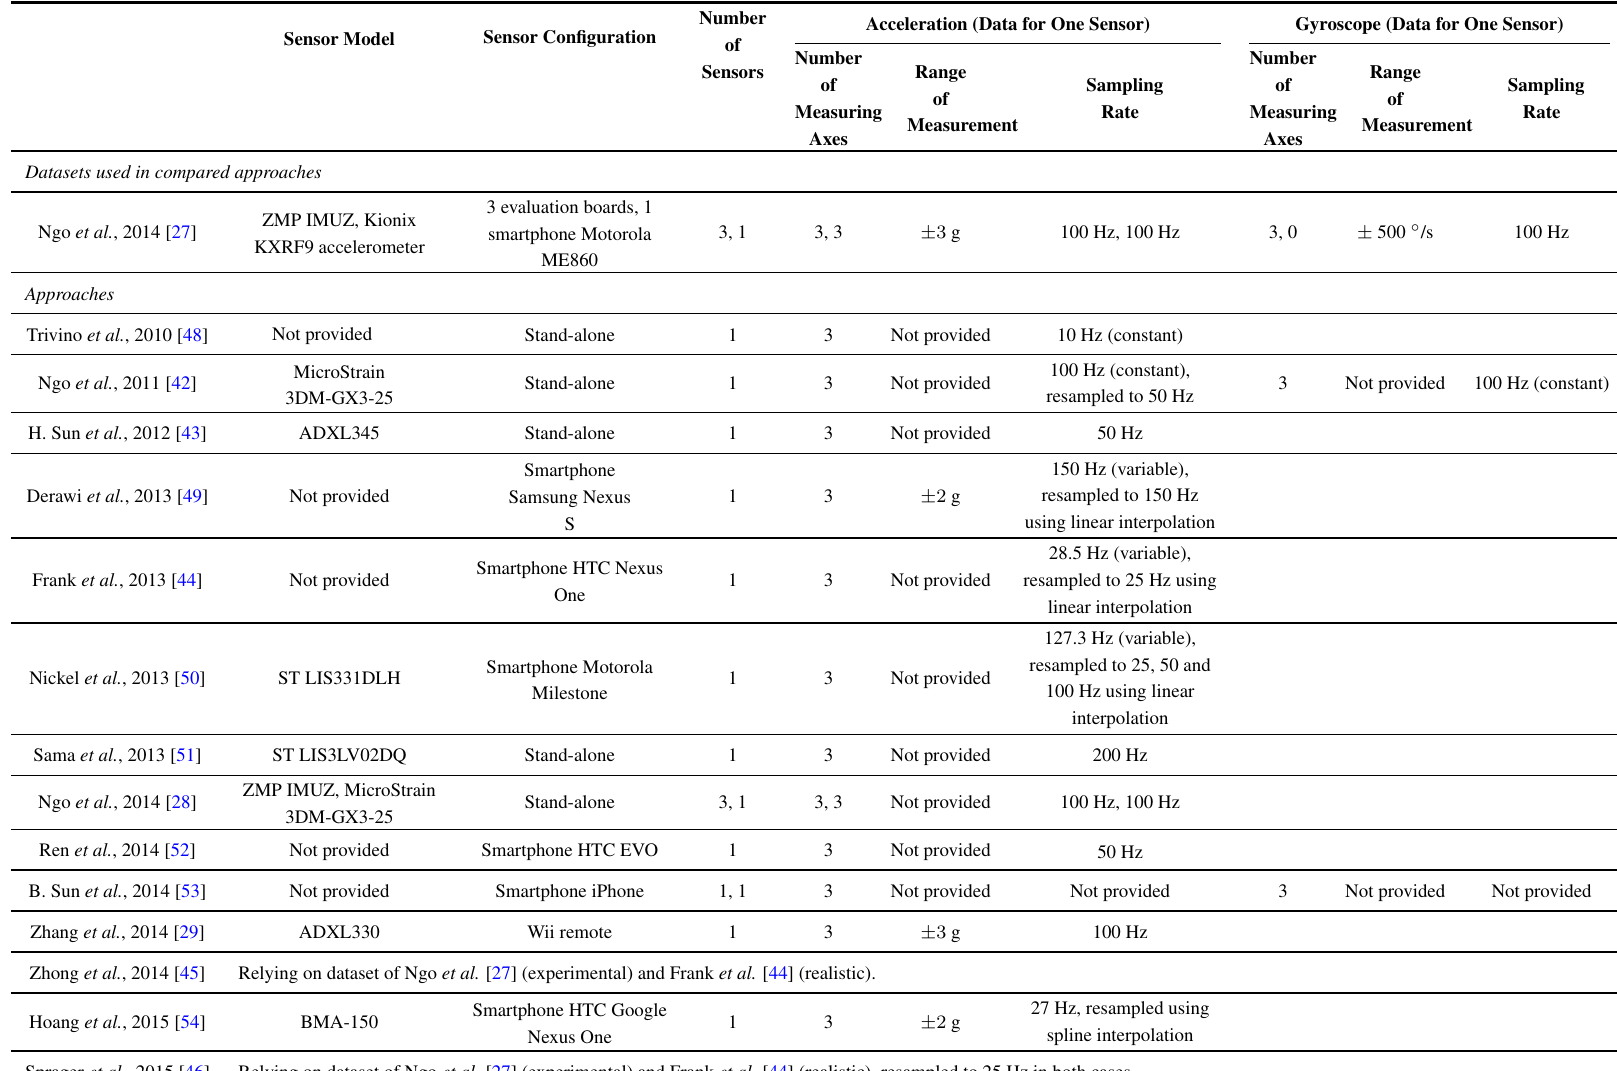
Table 1. Specifications of inertial sensors used in representative gait recognition